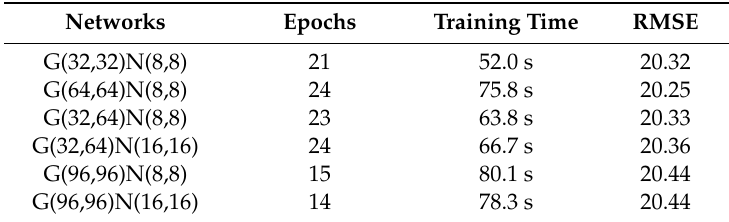
Table 3. Comparison of RMSE result (batch size = 64).